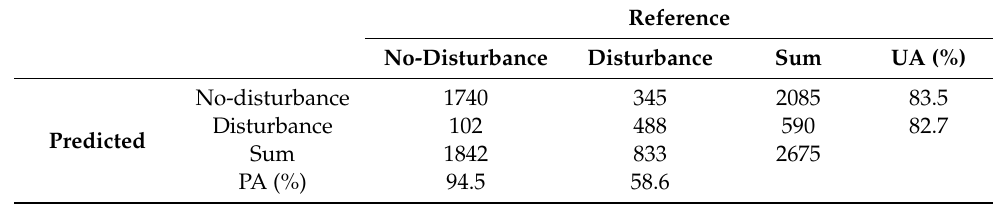
Table 2. Confusion matrix of RF disturbance probability model for each observation at the single pixel of Sentinel-1. Observations that had disturbance probabilities of greater than 50% were labeled as